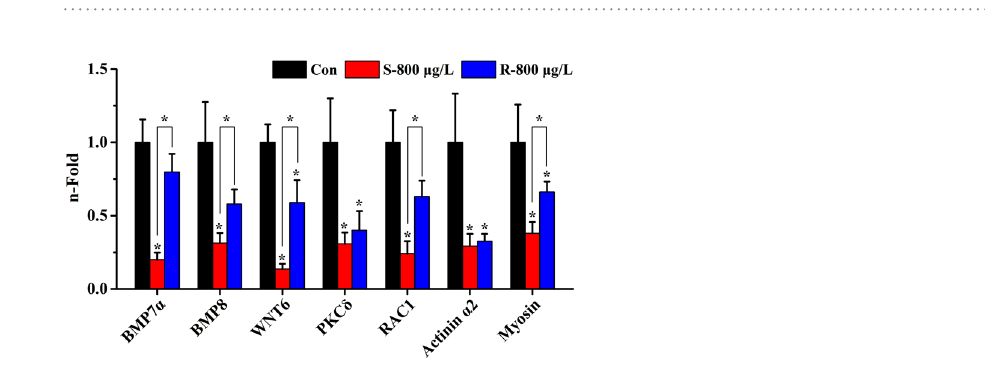
Table 4. Differentially methylated genes involved in developmental-related pathways.